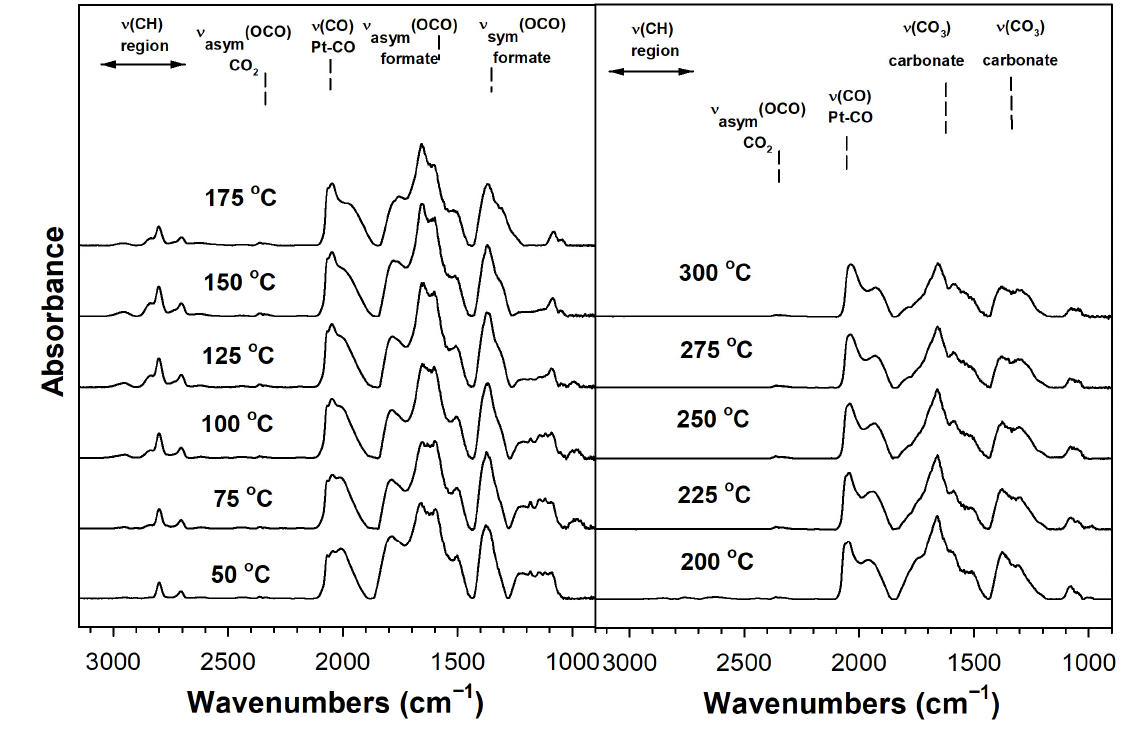
Figure 4. DRIFTS of steam reforming of formaldehyde over 1%Na-2%Pt/m-ZrO 2 .